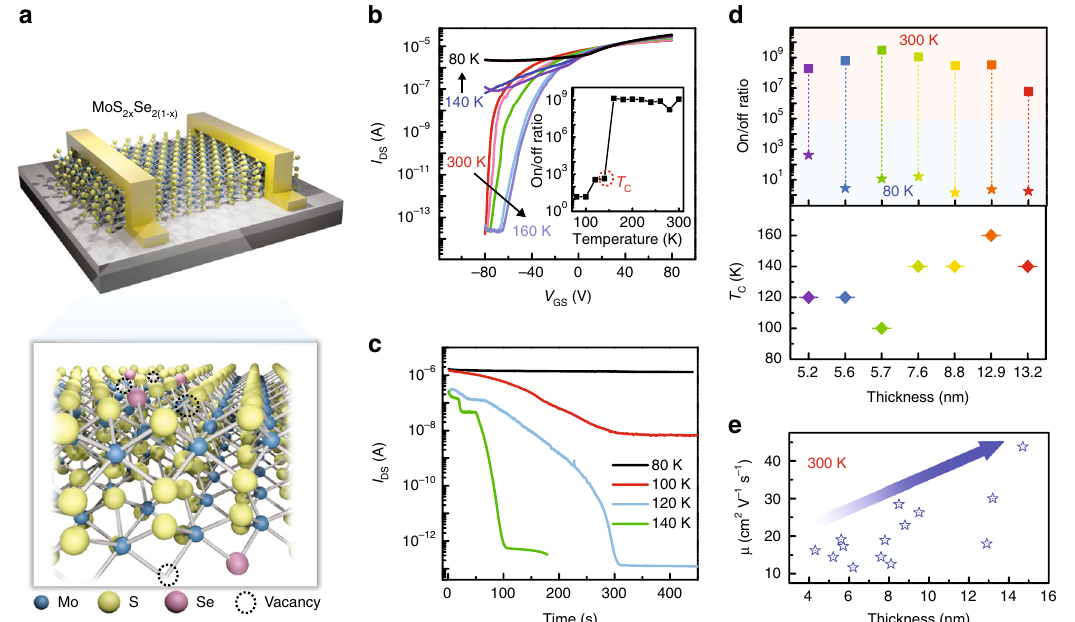
Fig. 2 Electrical transport properties of the device. a Structure and atomic schematic of the device. S vacancies and isoelectronic Se atoms synergistically serve to introduce expected trap centers in MoS 2x Se 2(1 − x) . b I DS – V GS curves under various temperatures. V DS = 1 V. Inset, plot of the current on/off ratios along with temperatures. The corresponding critical temperature ( T C ), at which the on/off ratio drops, is indicated by the red circle. c Time-resolved current measurement at V GS = − 80 V and V DS = 1 V. d The statistics of temperature-dependent on/off ratios (upper panel) and T C (lower panel) of a number of devices with various thicknesses. e The statistics of room temperature fi eld-effect mobilities ( μ ) obtained from 13 devices. Source data are provided as a Source Data fi